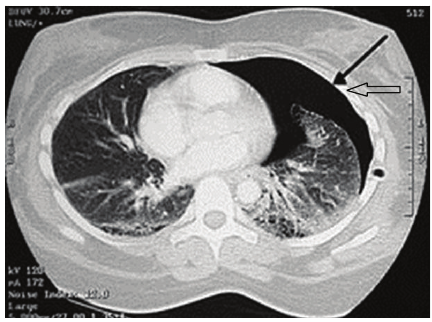
Figure 2: Chest CT scan showing left-sided pneumothorax.